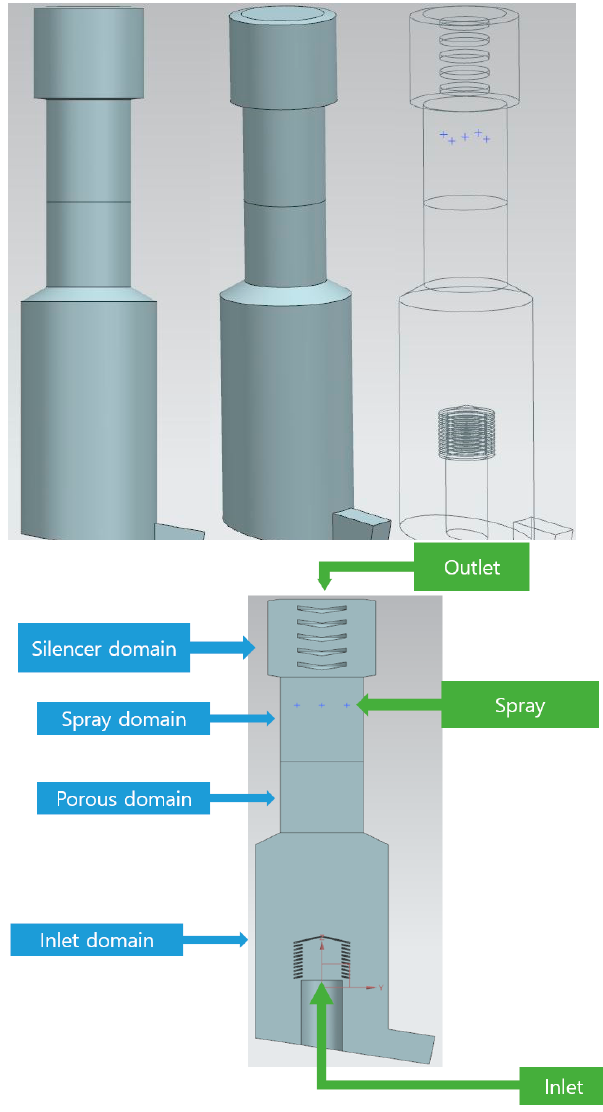
Figure 7. Overall shape and sectional view of composite scrubber.